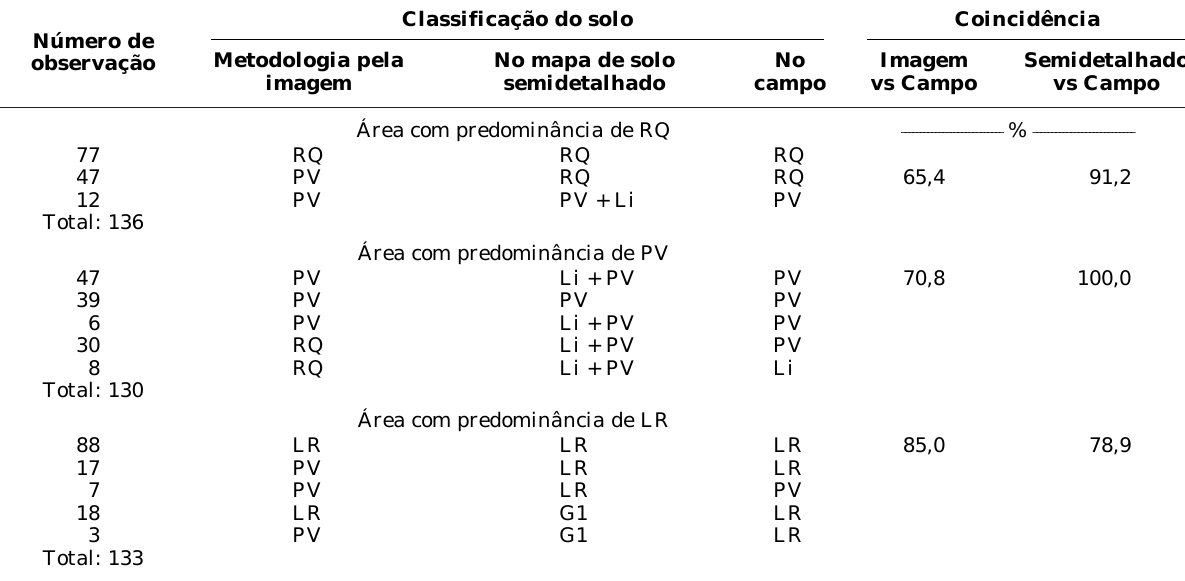
imagem, pelo mapa semidetalhado e pelas observações de